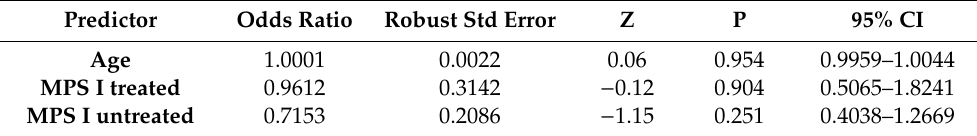
Table 12. Object discrimination mixed e ff ects logistic regression model. Analysis of MPS I a ff ected groups compared to normal group for choice (correct versus incorrect) at each session x trial and